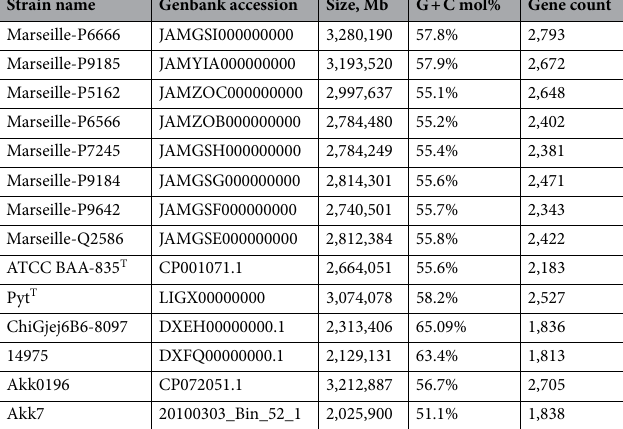
Table 3. Genomic characteristics of studied Akkermansia species and other closely-related